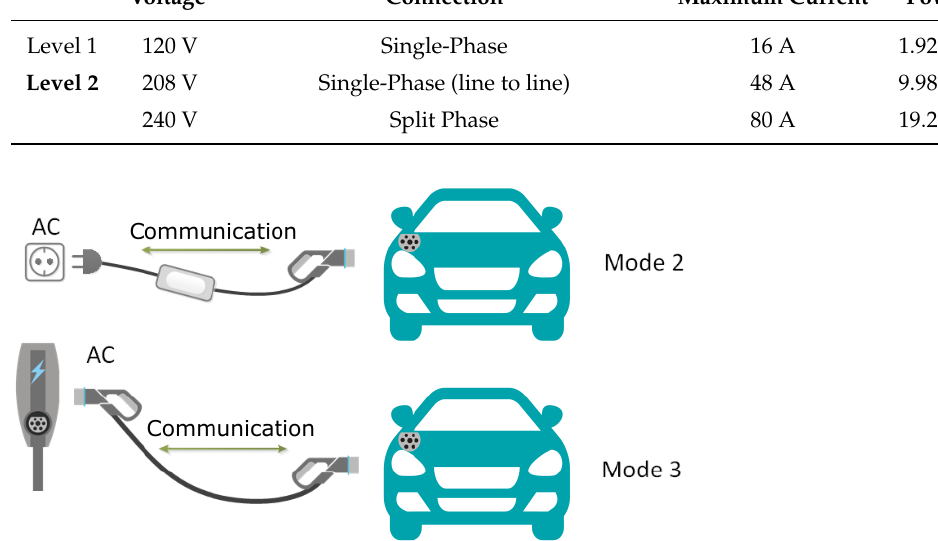
Figure 1. Illustration of AC charging modes (Mode 2 and Mode 3) as per IEC 61851-1